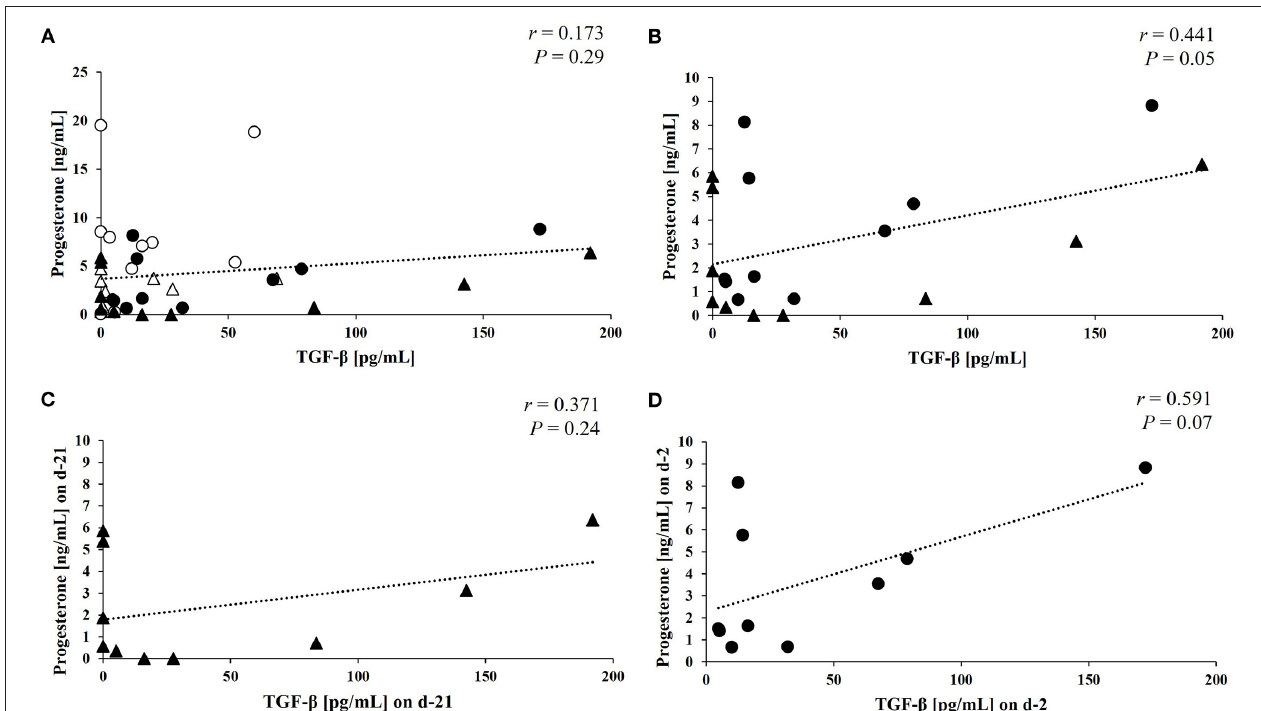
FIGURE 3 | Pearson correlation coefficients between progesterone and TGF- β concentrations. Pearson correlation coefficients between progesterone concentrations (ng/mL) and TGF- β concentrations (pg/mL) in uterine samples: (A) Overall relationship between concentrations for both resulting non-pregnant and pregnant cows. Non-pregnant cows on d − 21 are indicated by the open triangles, non-pregnant cows on d − 2 are indicated by the open circles, pregnant cows on d − 21 are indicated by the black triangles, and pregnant cows on d − 2 by the black circles, (B) Relationship between concentrations for pregnant cows, (C) Relationship between concentrations for pregnant cows on d − 21, and (D) Relationship between concentrations for pregnant cows on d − 2.